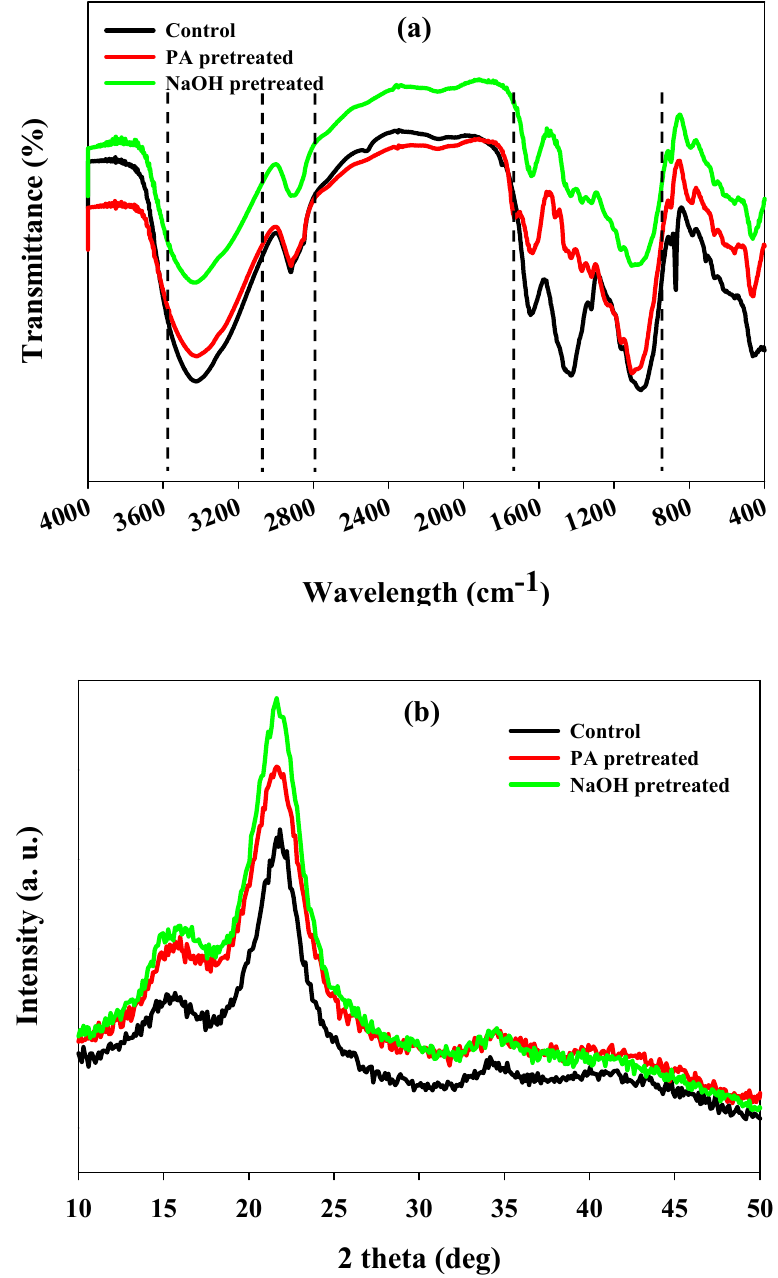
Figure 4. ( a ) Fourier transform infrared spectroscopic (FTIR) spectrum, ( b ) X-ray diffraction (XRD) pattern of untreated WH, peracetic acid pretreated and NaOH pretreated WH biomass under optimized conditions.